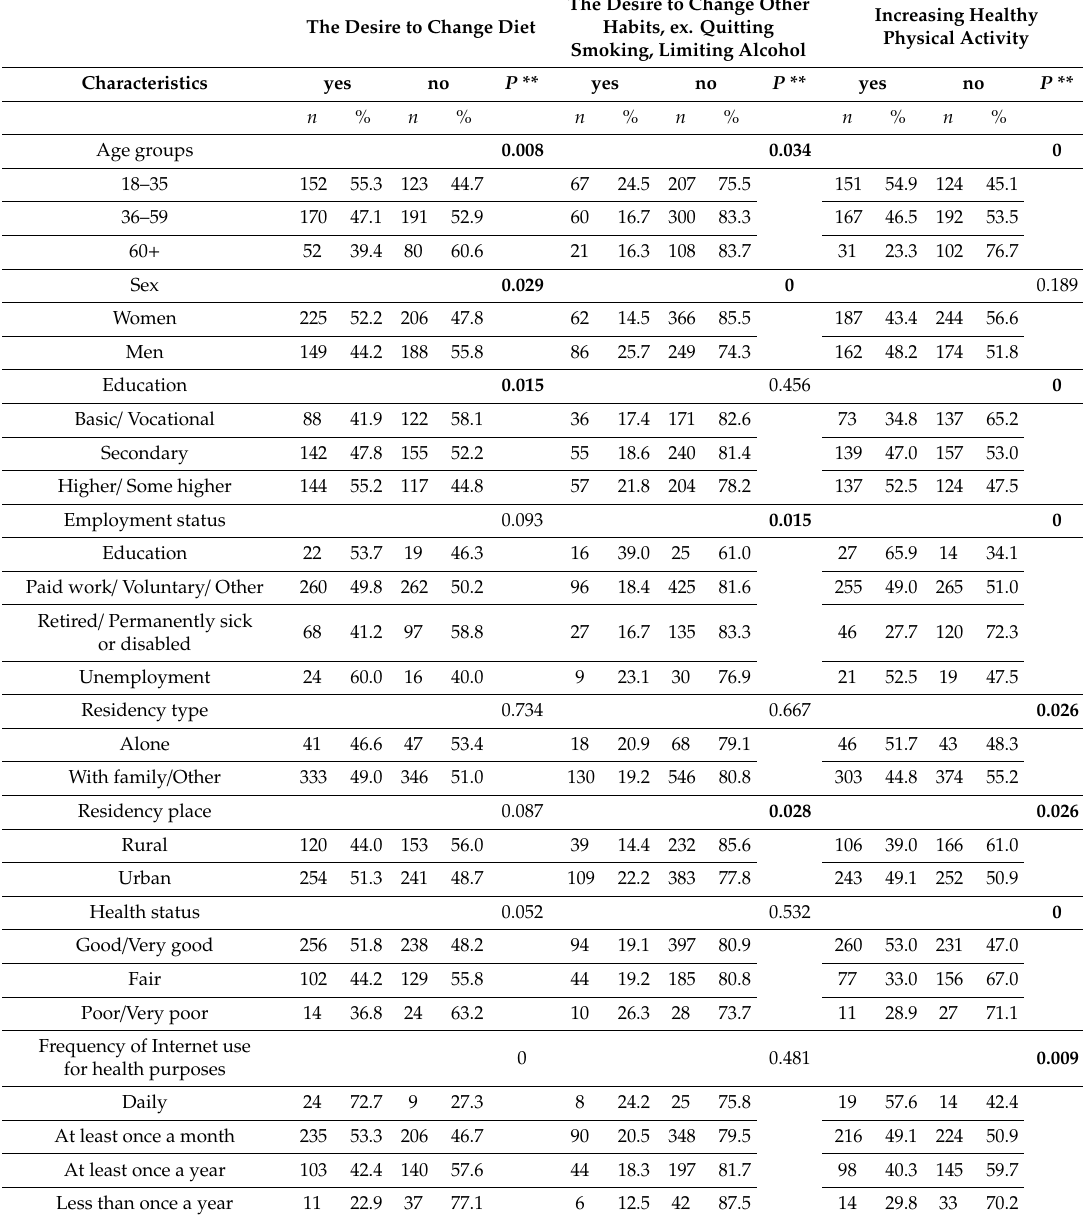
Table 5. Self-reported pro-health behavior triggered by health or disease information obtained from the Internet